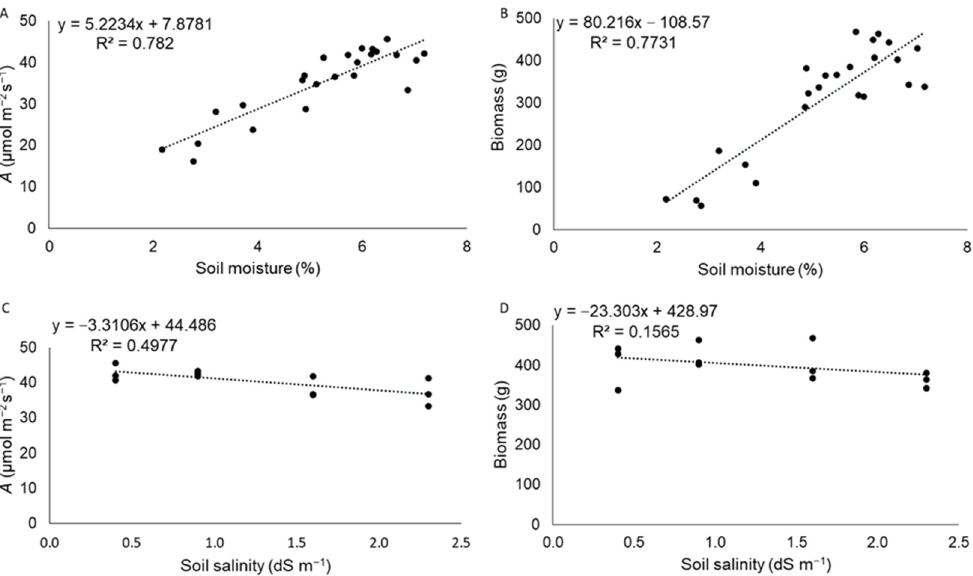
Figure 8. Photosynthetic rate A , and total biomass production per plant of maize as a function of soil moisture ( A , B ) and soil salinity ( C , D ).